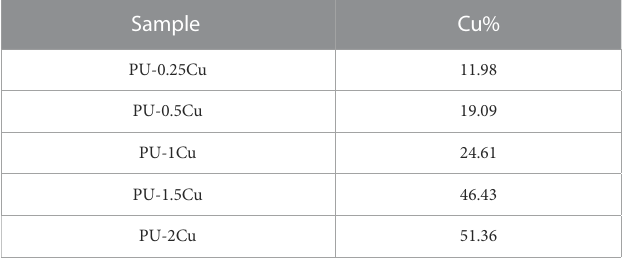
TABLE 2 Proportion of Cu element determined by XPS.